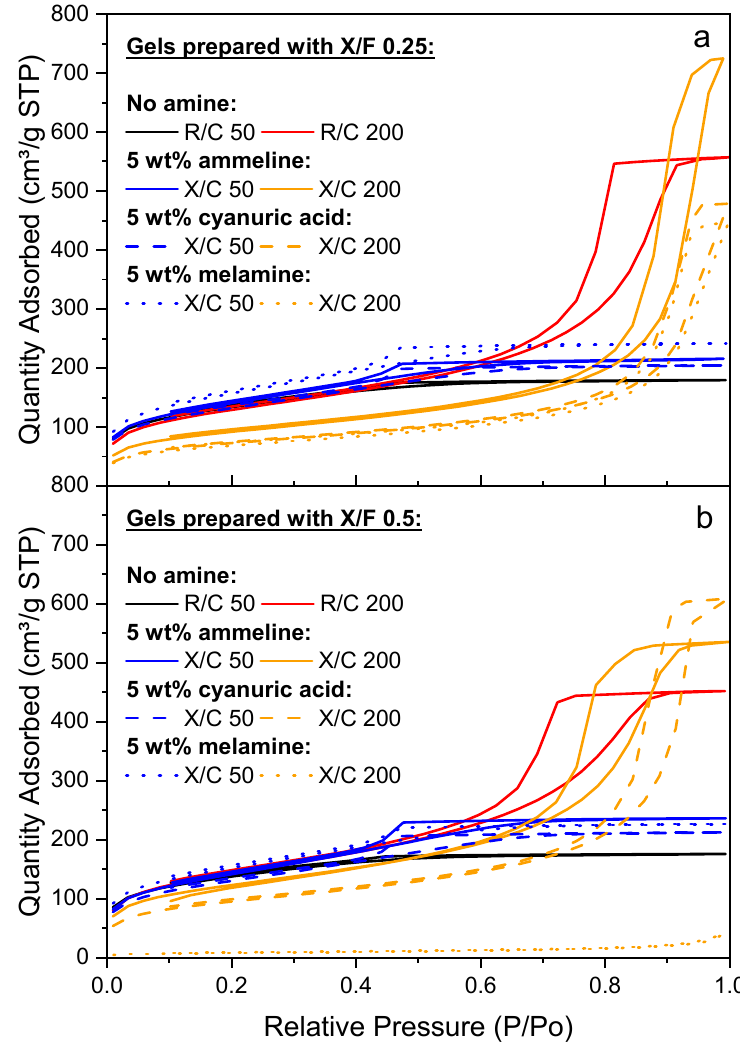
Figure 3. Nitrogen sorption isotherms for gels prepared with 5 wt% of additives and with ( a ) X/F 0.25 and ( b ) X/F 0.5.